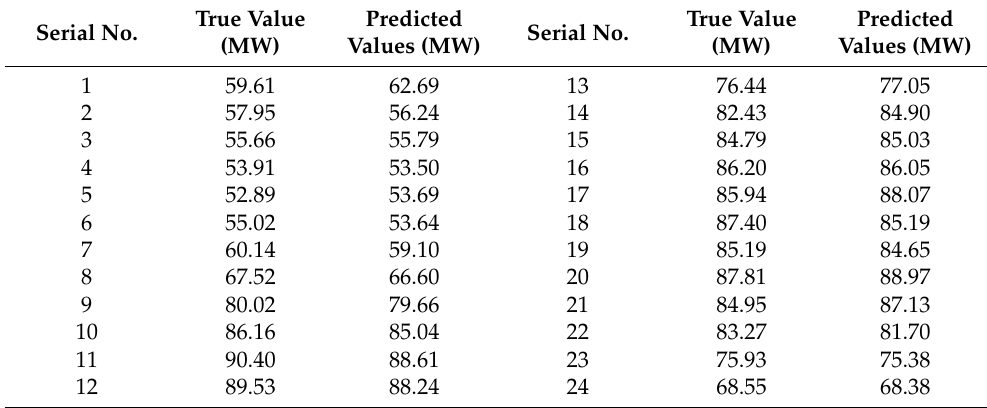
The comparison of the prediction curves generated, based on the ISSA-LSTM predic- tion model, with the true value curves of the load data is shown in Figure